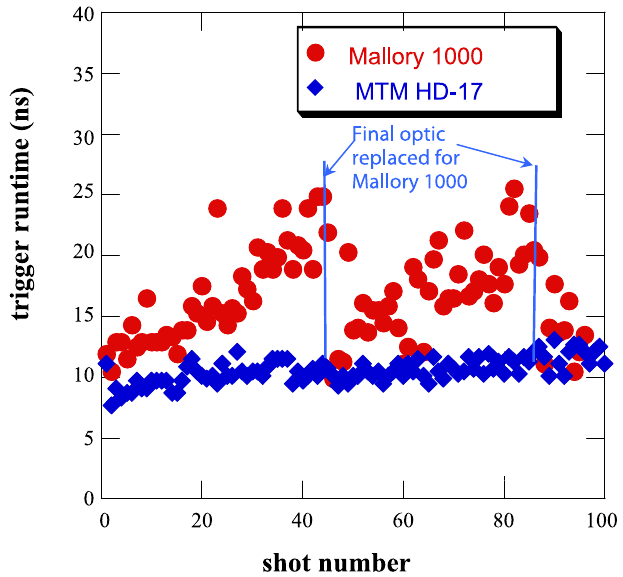
FIG. 19. (Color) Comparison of trigger runtime for Mallory 1000 and HD-17, both are 90% W, 10% Cu-Ni sintered mate-